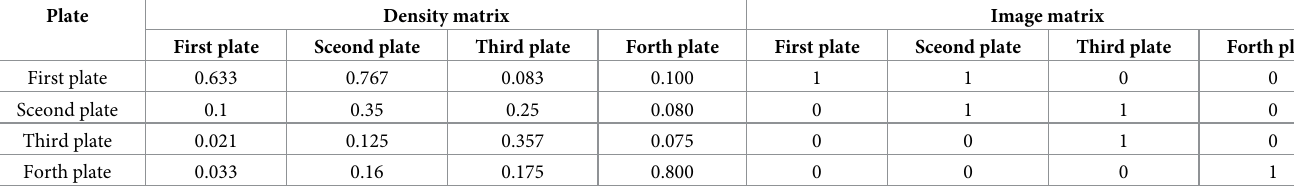
Table 3. Density matrix and image matrix of innovation efficiency of China’s the NEV industry in 2019. Plate